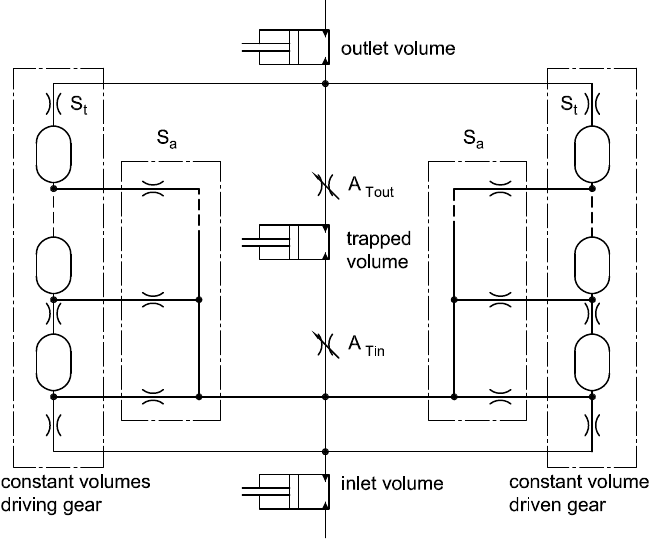
Figure 6. Equivalent hydraulic circuit based on the MC model.